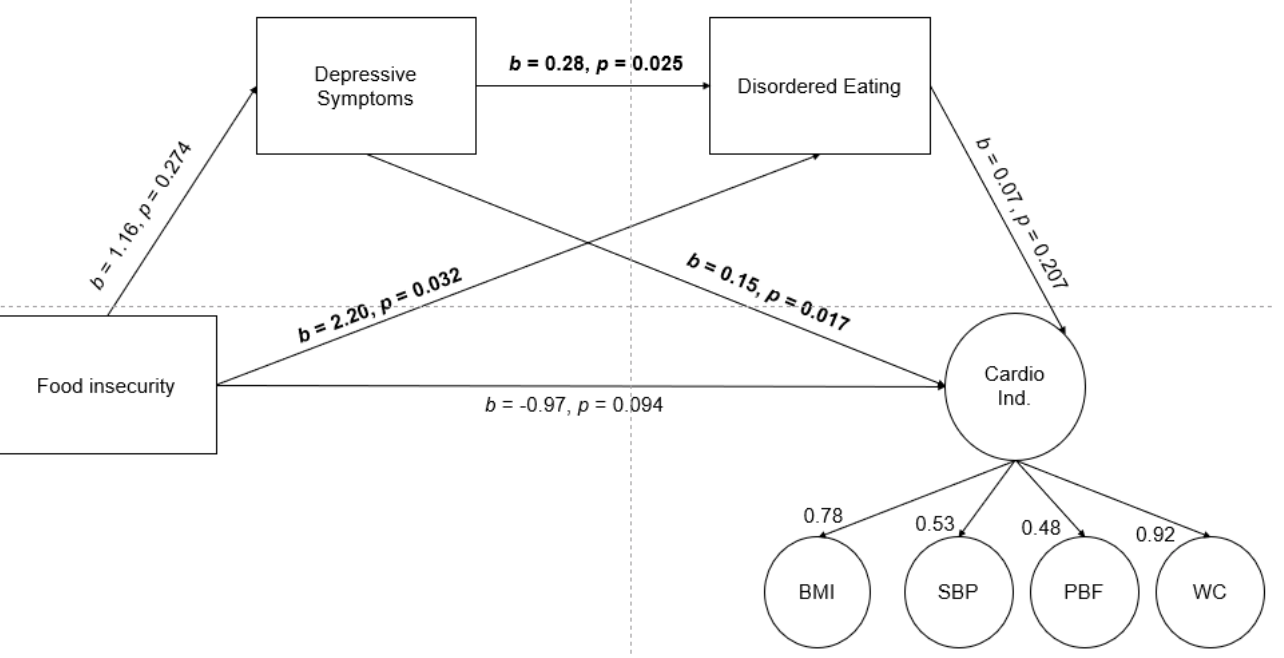
Figure 1. Test of the biobehavioral model of food insecurity with a latent cardiometabolic risk indicator variable as the outcome. Unstandardized effects presented for the structural equation model. Standardized factor loading estimates for the latent variable. Cardio Ind. = cardiometabolic risk indicators. BMI = body mass index. SBP = systolic blood pressure. PBF = percent body fat. WC = waist circumference. Bolded estimates are significant at p < 0.05.